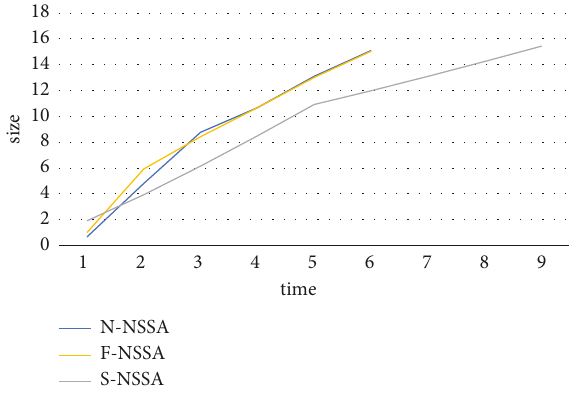
Figure 9: Comparison of different data